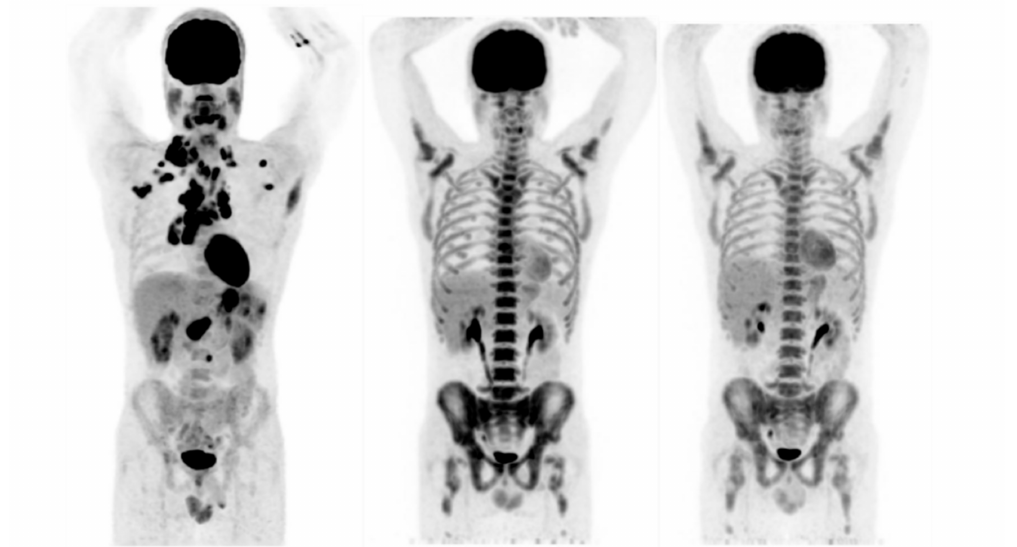
Figure 2. Maximum intensity projection (MIP) of positron emission tomography (PET) images at baseline, at interim and at the end-of-treatment (EOT) for a patient showing complete metabolic response (CMR), according to Lugano evaluation, both at T1 and